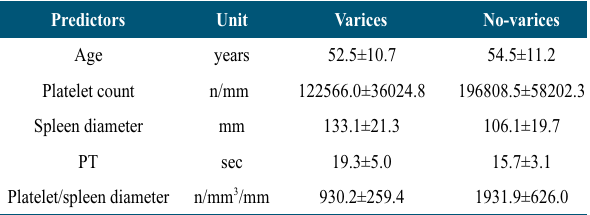
Table 3: Means ± SD of different predictors of study patients in relation to presence or absence of esophageal varices.